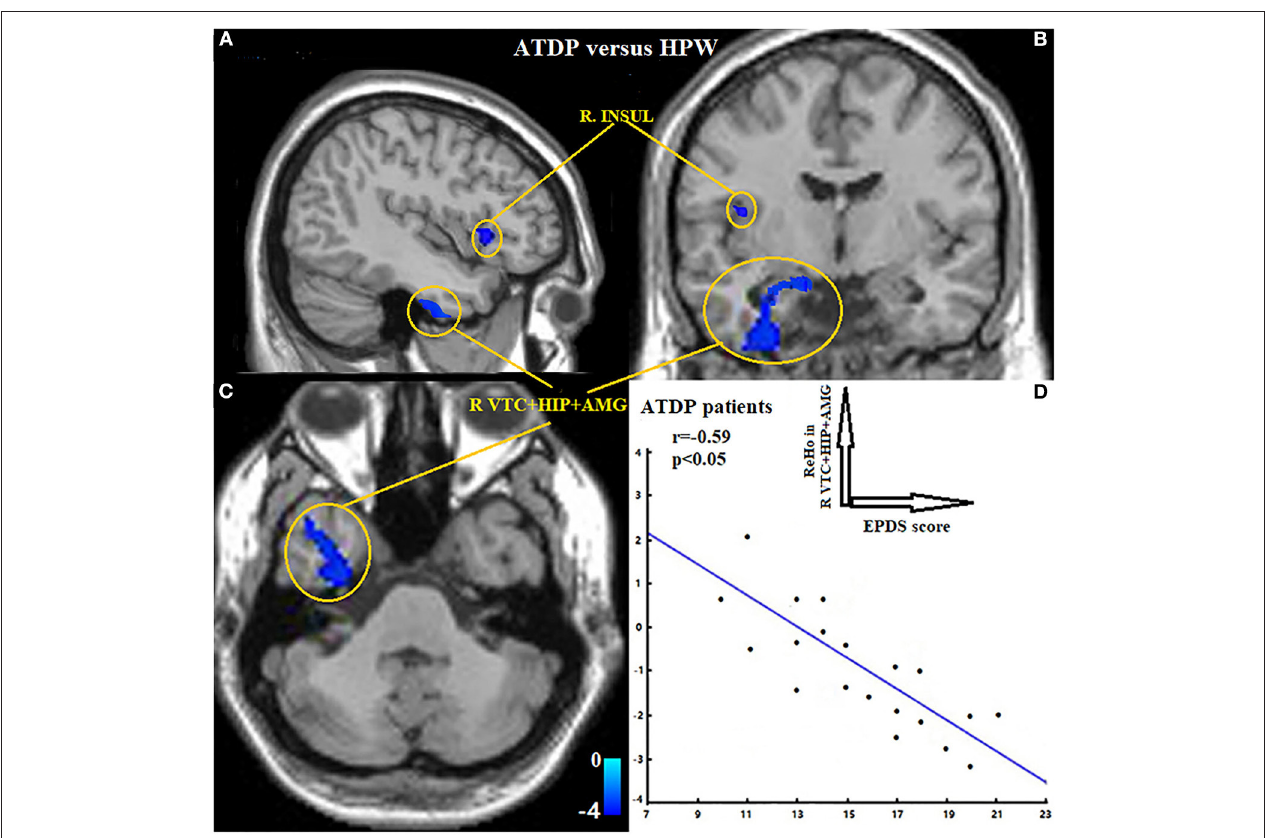
FIGURE 2 | (A–C) Exhibited ANDP patients showed decreased ReHo in the right insular, the cluster covering right VTC, HIP, and AMG. Blue to green indicates the regions that exhibit decreased ReHo in ANDP vs. HPW ( p < 0.05, FDR-corrected). (D) Exhibited EPDS scores of ANDP patients were negatively associated with the ReHo of ANDP patients in the right VTC, HIP, and AMG ( r = − 0.59, p < 0.05). HPW, healthy pregnant women; EPDS, Edinburgh Postnatal Depression Scale; AMG, amygdala; HIP, hippocampus; INSUL, insular; VTC, ventral temporal cortex. ReHo, regional homogeneity; R, right side.